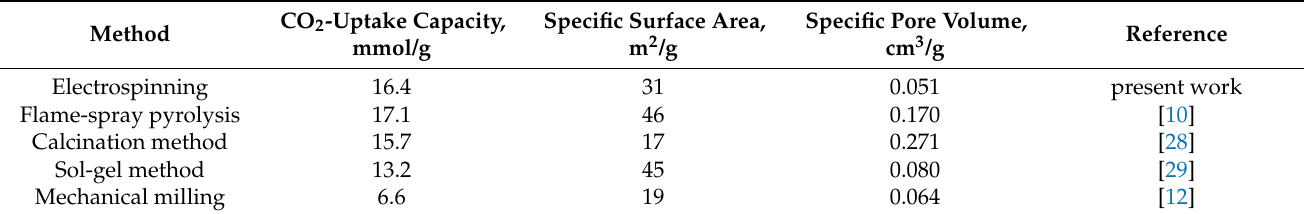
Table 1. Comparison of synthetic CaO sorbents obtained by various